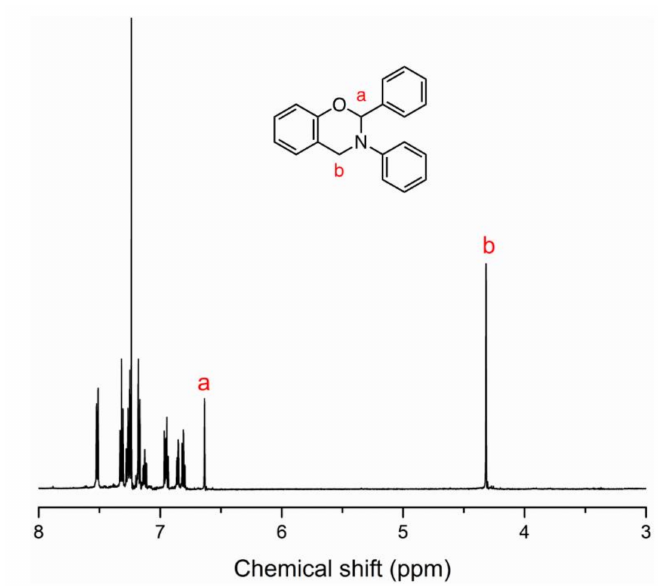
Figure 6. 1 H NMR spectrum of PH-a-[ 2 ]